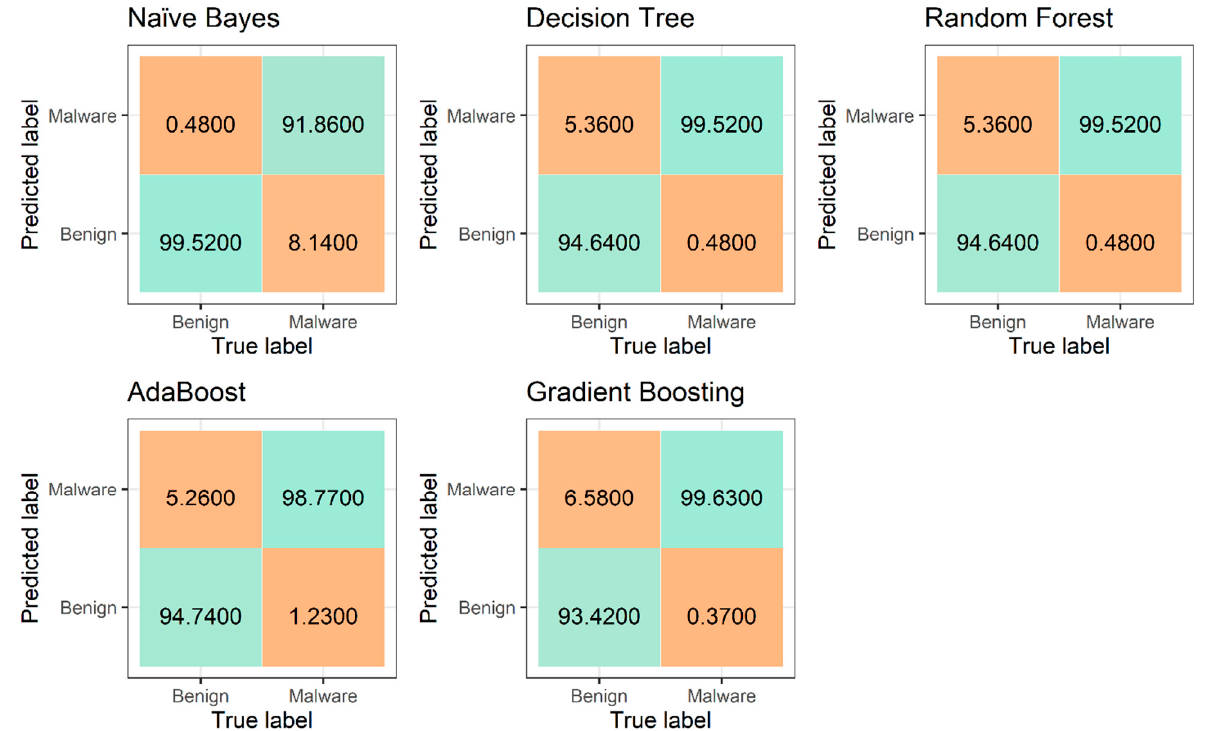
Figure 4. Confusion matrices of baseline machine learning methods.